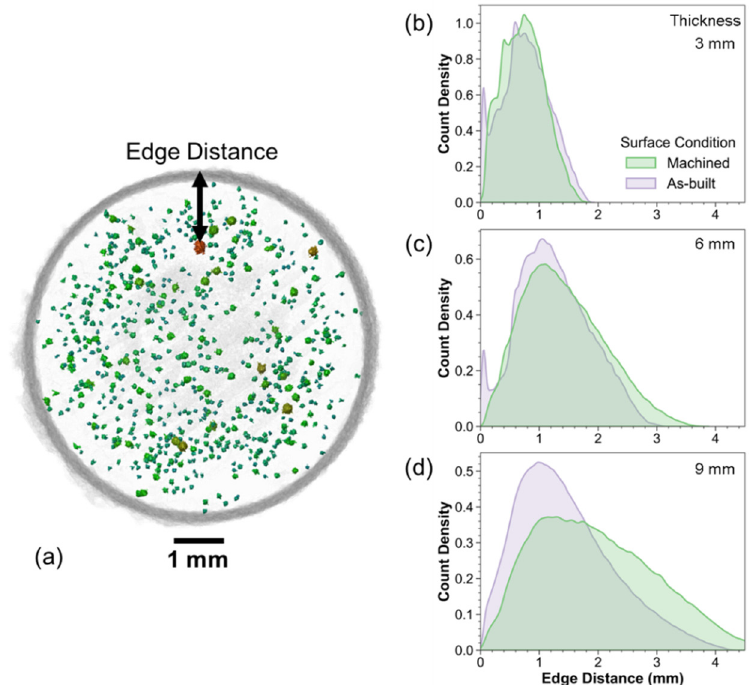
Figure 8. Pore distribution as a function of edge distance, which is defined as the distance of the surface of a pore to the free surface of the specimen as represented in the top view projection in ( a ). Count density plots for the three thickness levels (3, 6, and 9 mm) are shown in ( b – d ), respectively. The highest density of porosity is located at a ring around 0.7–1.1 mm from the surface. The final metric for describing the pore geometry is morphology, which can be de- scribed in terms of its sphericity, aspect ratio, and radius of curvature. The sphericity defines the ratio of the surface area of the pore to the surface area of a sphere with an equivalent volume, as shown in Figure 9a. Sphericity is defined as